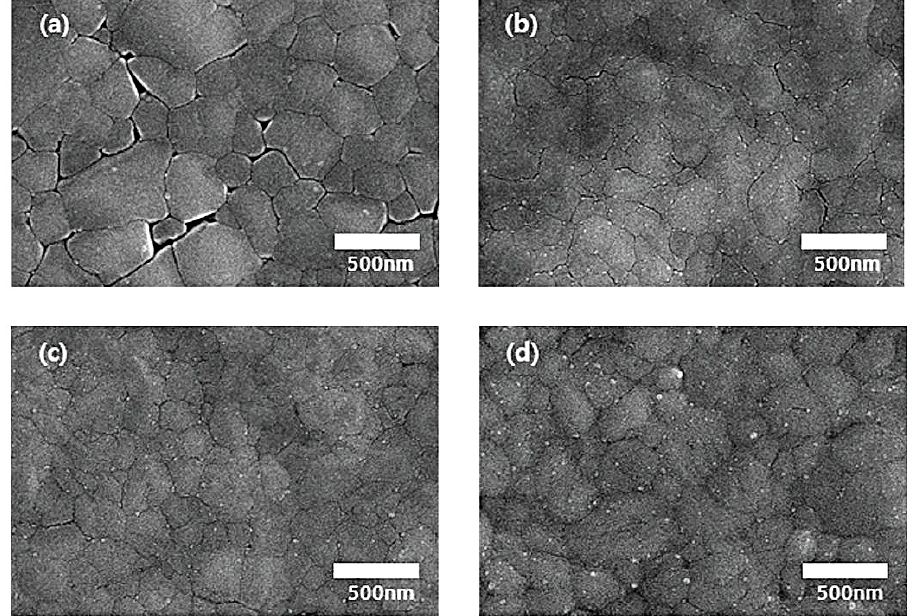
Figure 2. Top-view SEM images of perovskite films with ( a ) 0, ( b ) 2.5, ( c ) 5, and ( d ) 7.5 mol% ce- sium doping